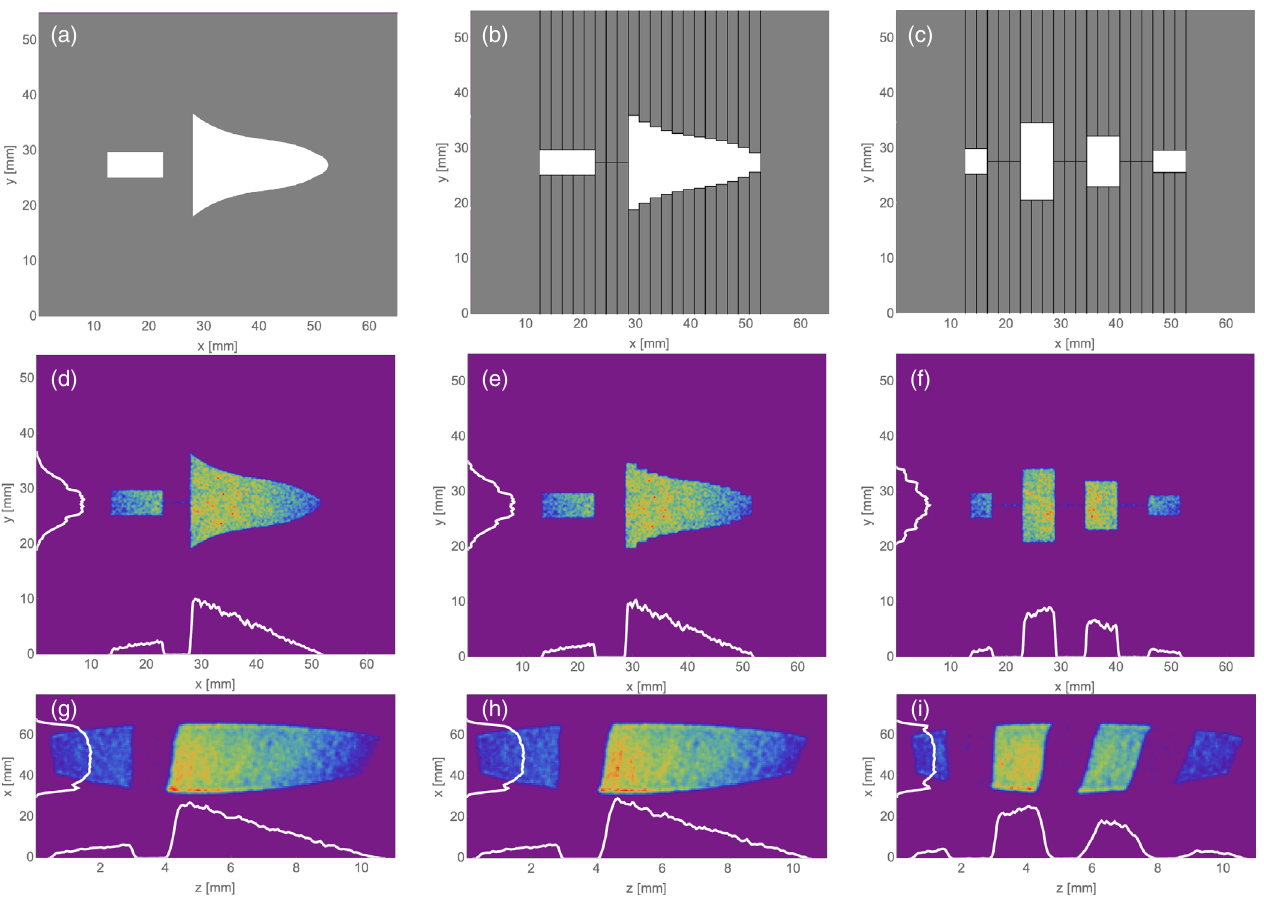
FIG. 2. Simulated screen images with vertical and horizontal projections for three mask configurations. The top row (a – c) shows the simulated mask used to shape the electron beam; gray regions are static mask elements while gray regions with black borders are 2 mm wide MLC leaves that move vertically to adjust the aperture. The middle row (d – f) shows the electron bunch profile shortly downstream of the mask while the bottom row (g – i) shows the beam after the EEX beamline and a transverse-deflecting cavity, revealing the longitudinal structure of the beam. The first column shows a smooth mask for a triangle current profile with witness bunch, the second column is the MLC set to approximate the smooth mask, and the final column is a three-driver bunch profile with a witness. Refer to Fig. 1 for the locations of the mask and screens within the context of the